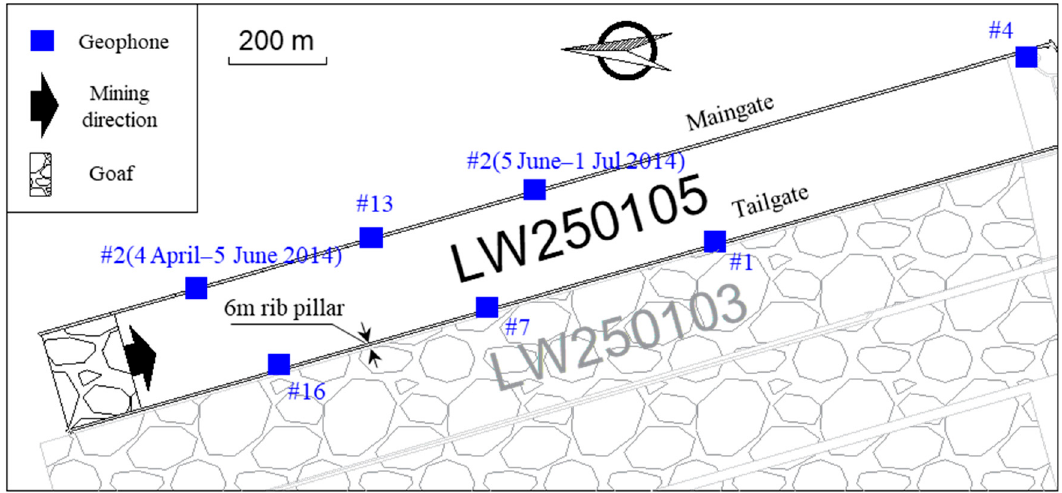
Figure 2. LW250105 layout and geophone distribution in roadways. The location of Geophone #2 was modified on 5 June